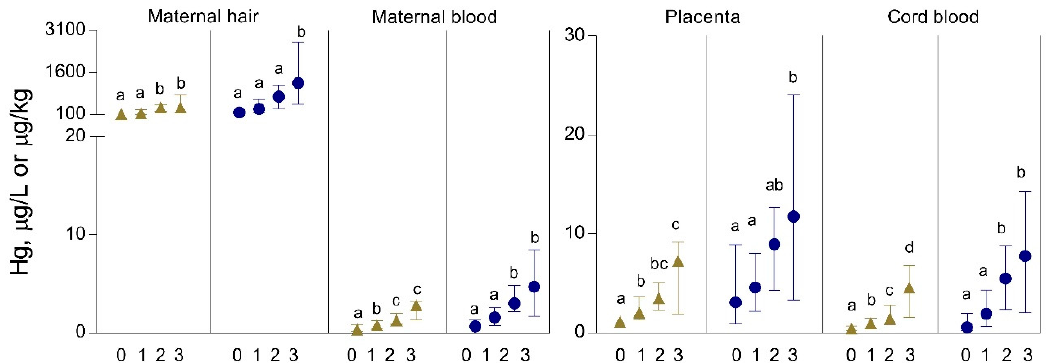
Figure 2. Concentrations of Hg in maternal hair and blood, placenta, and cord blood in study participants from Croatia, continental ( ▲ ) and coastal area ( ● ), related to the frequency of seafood (fish) consumption per week. Subgroups (number of participants is given in Table 1, except the number of analyzed hair samples in the continental area indicated here in parentheses): 0—no consumption ( n = 11); 1—consumption ≤ 1 per week ( n = 34); 2—consumption >1–2 per week ( n = 20); 3—consumption >2 per week ( n = 6). Data are presented as the median and interquartile range (25%–75%). Statistically significant differences ( p < 0.05) between the subgroups tested by one ‐ way ANOVA and post hoc Bonferroni test are indicated by different letters.